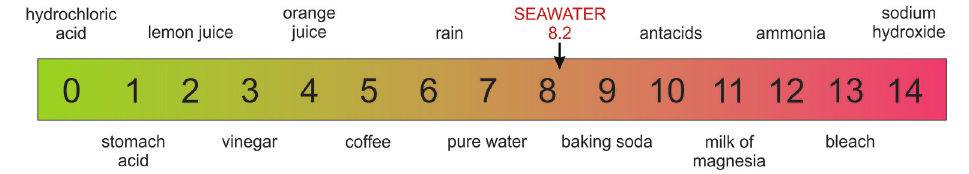
Fig. 1. Position of oceanic waters on the pH